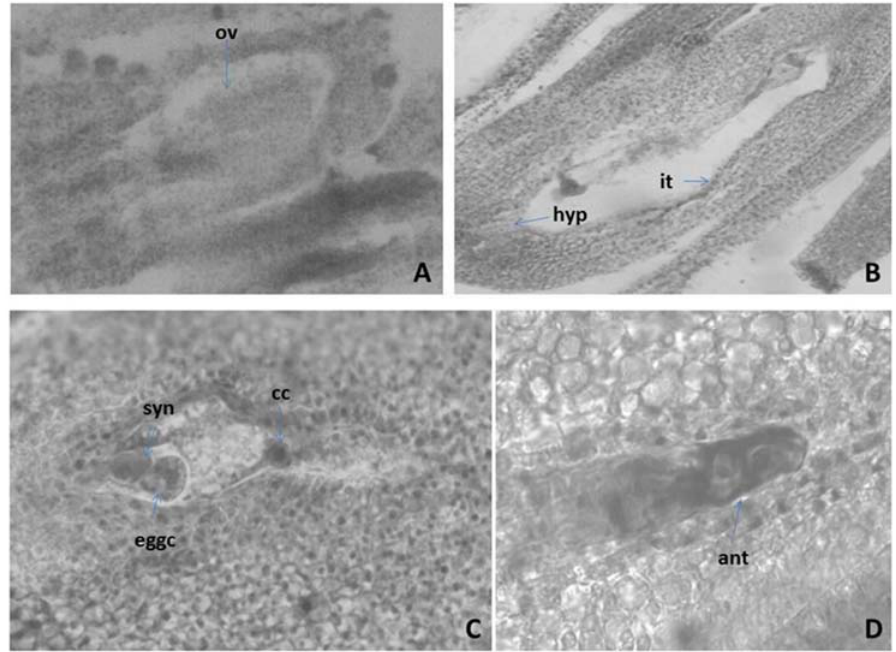
Figure 2. Ovule and development of the female gametophyte revealed after light microscopy obser- vations: ( A ) Anatropous unitegmic ovule; ( B ) Mature Polygonum -type embryo sac (ES); ( C ) Mature ES with egg apparatus and central cell; ( D ) Antipodals in the ES—cavity ov—ovule, hyp—hypostase it—integumental tapetum (endothelium), eggc—egg cell, syn—synergids, cc—central cell, ant—antipodal. Magnification: ( A , B ) (×100); ( C , D ) (×400).